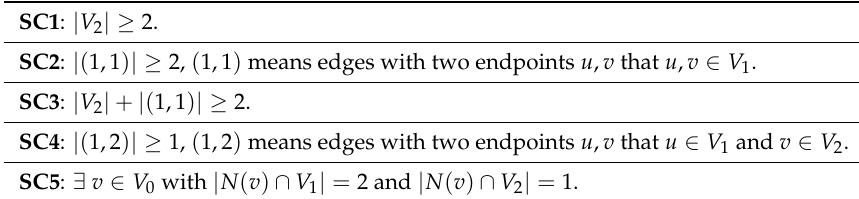
Table 2. Sufficient conditions for r f ( V ) > 0.2 r 1 ( r 1 =